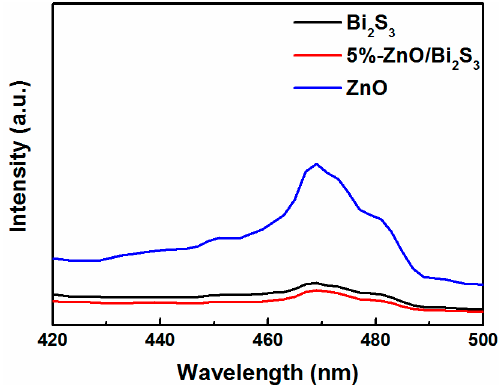
Figure 7. The PL spectra of ZnO, Bi 2 S 3 and 5%-ZnO/Bi 2 S 3 composite.